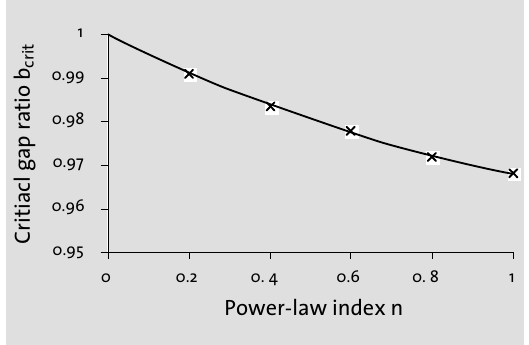
Figure 8 (left): The critical gap ratio, bcrit, below which the shear rate cannot be considered constant - to within 5% - throughout the gap, plotted for different values of power-law index. Figure 9 (right): The change of cylinder-edge shear rate with increase in container size for various values of power-law index. Also shown as a dotted line is where approximately the shear rate becomes insensi- tive - to within 1% - to the container size.